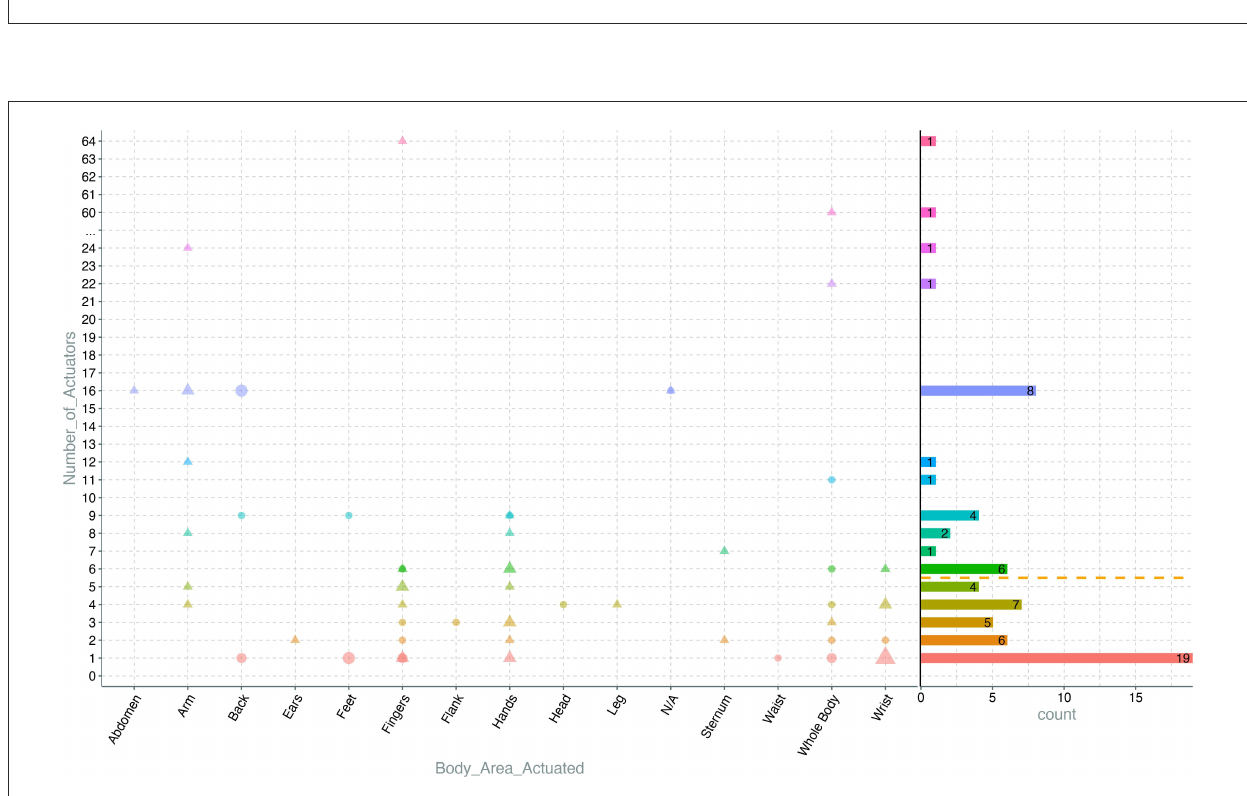
FIGURE11 Distribution of the evaluation measure goals for each listening situation; a triangle indicate a wearable device, a circle indicates a fixed device and the size of the shape represents the amount of similar devices; items on X axis are note exclusive.